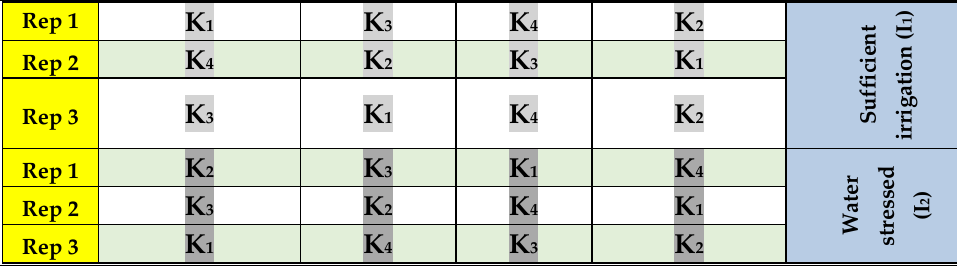
Figure 2. I 1 (sufficient water) and I 2 (water stress) indicate the main treatments applied to plots, and K 1 (0 K 2 O ha −1 ), K 2 (40 kg K 2 O ha −1) , K 3 (80 kg K 2 O ha −1 ) and K 4 (120 kg K 2 O ha −1 ) indicate Rep = treatment